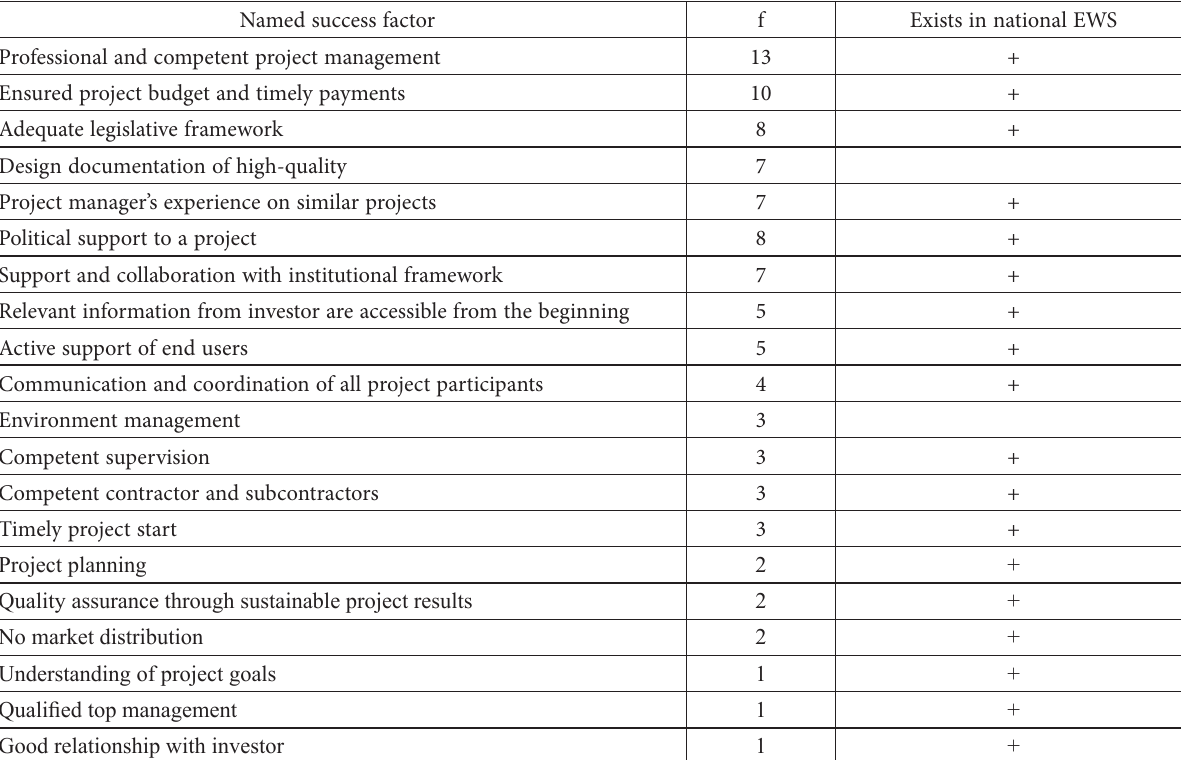
Table 10. Results of qualitative analysis of project management success factors Named success